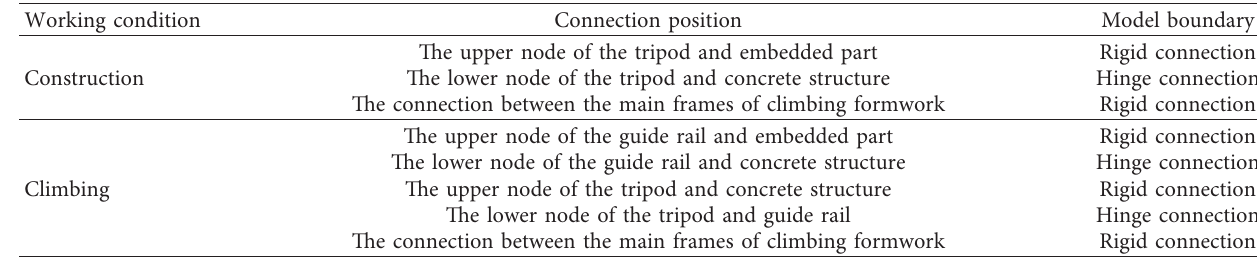
Table 3: Boundary condition of the finite element model.